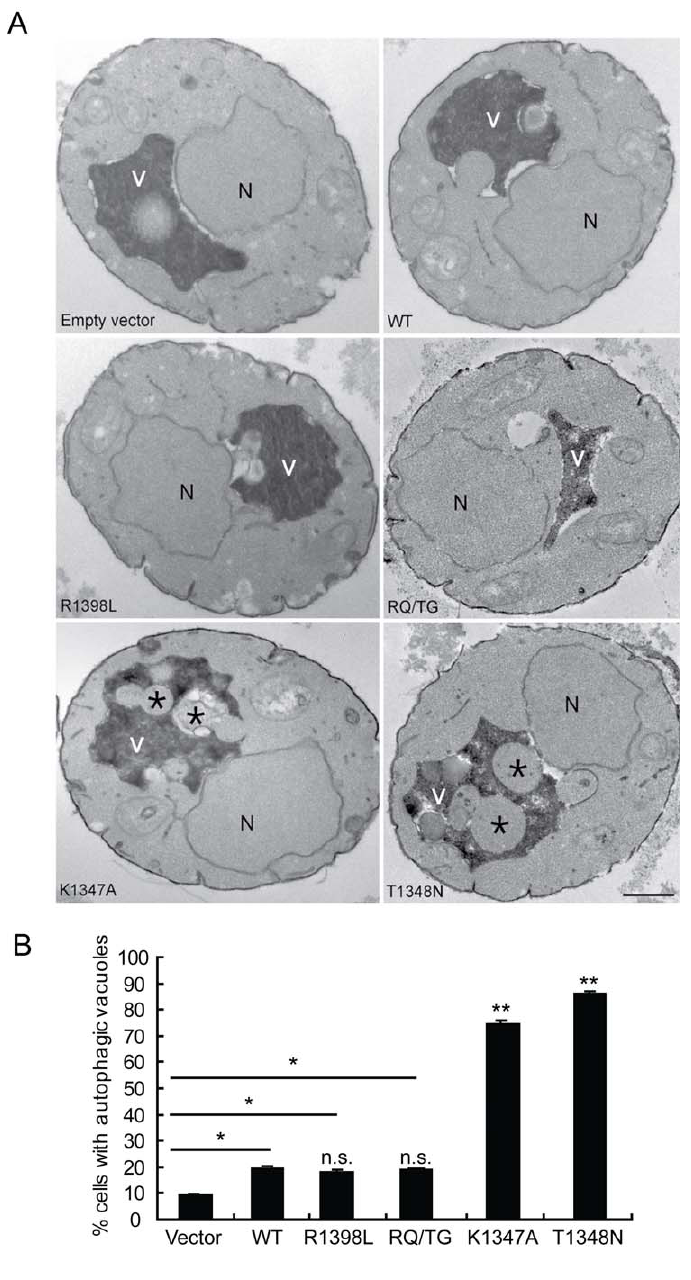
Figure 4. LRRK2 GTPase variants induce defects in autophagy. (A) Transmission electron micrographs demonstrating increased autophagic vacuoles (asterix) within the vacuole of yeast cells expressing the toxic GTPase variants, K1347A or T1348N, in the LRRK2 GTP-COR-Kin fragment. V, vacuoles; N, nucleus; Scale bars, 2 m m. (B) Quantification of autophagic defects showing the percentage of cells with autophagic vacuoles. A total of 100 cells were analyzed in one experiment and data are representative of at least two independent experiments. Bars represent the mean 6 SEM. Data were analyzed for statistical significance by two-tailed unpaired Student’s t -test relative to WT LRRK2, or by pair-wise comparisons with vector controls where indicated by horizontal lines (* P , 0.01 and ** P , 0.001). n.s. , non-significant versus a -synuclein expression in yeast most likely occur via impairment of (CPY) and alkaline phosphatase (ALP) proteins from the endo- distinct vesicular trafficking pathways. plasmic reticulum (ER) to the vacuole by pulse-chase analysis (data not shown), which represent two distinct biosynthetic transport pathways that converge upon the vacuole in addition to the endocytic pathway. Notably, human a -synuclein expression in yeast manifests prominent defects in normal CPY and ALP trafficking consistent with derangements in ER-to-Golgi vesicular trafficking [30]. Accordingly, toxicity induced by LRRK2 and